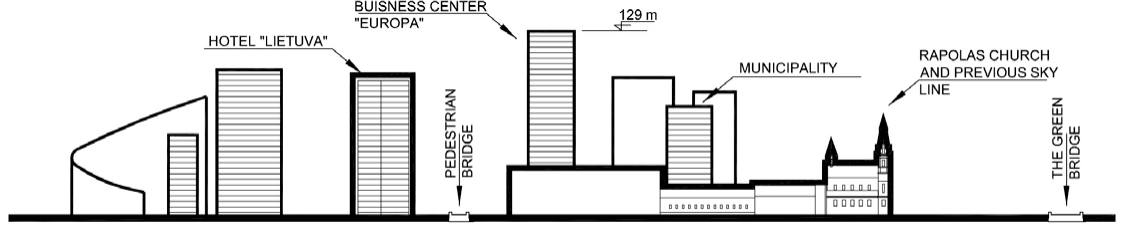
fig. 6. Due to its height, the complex of Vilnius high-rise buildings overshadows the historical ensemble of the church by diminishing its scale and hence minimising the visual impact on the space of the river